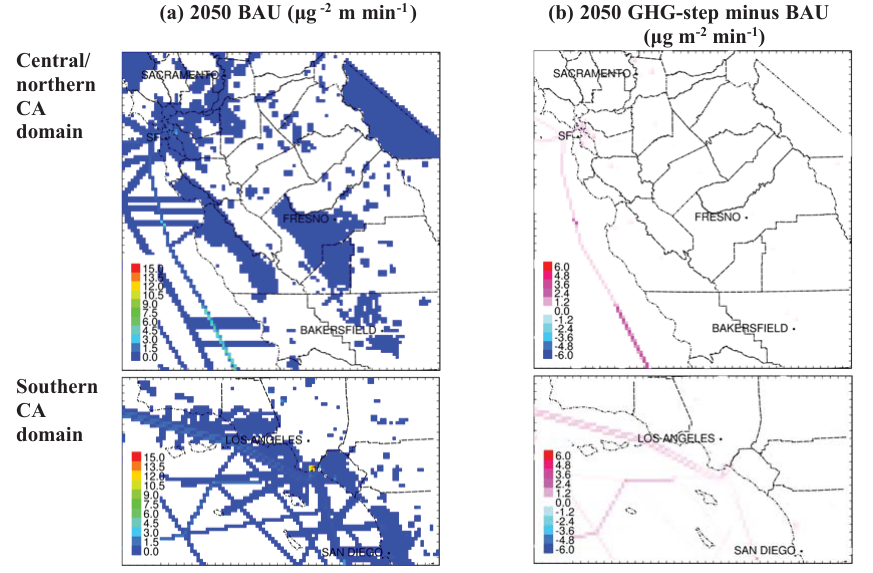
Figure 14. Particulate matter emissions from marine and aviation sources in the BAU scenario (a) and emissions change in the GHG-Step scenario (b) . Units are µgm − 2 min − 1 .